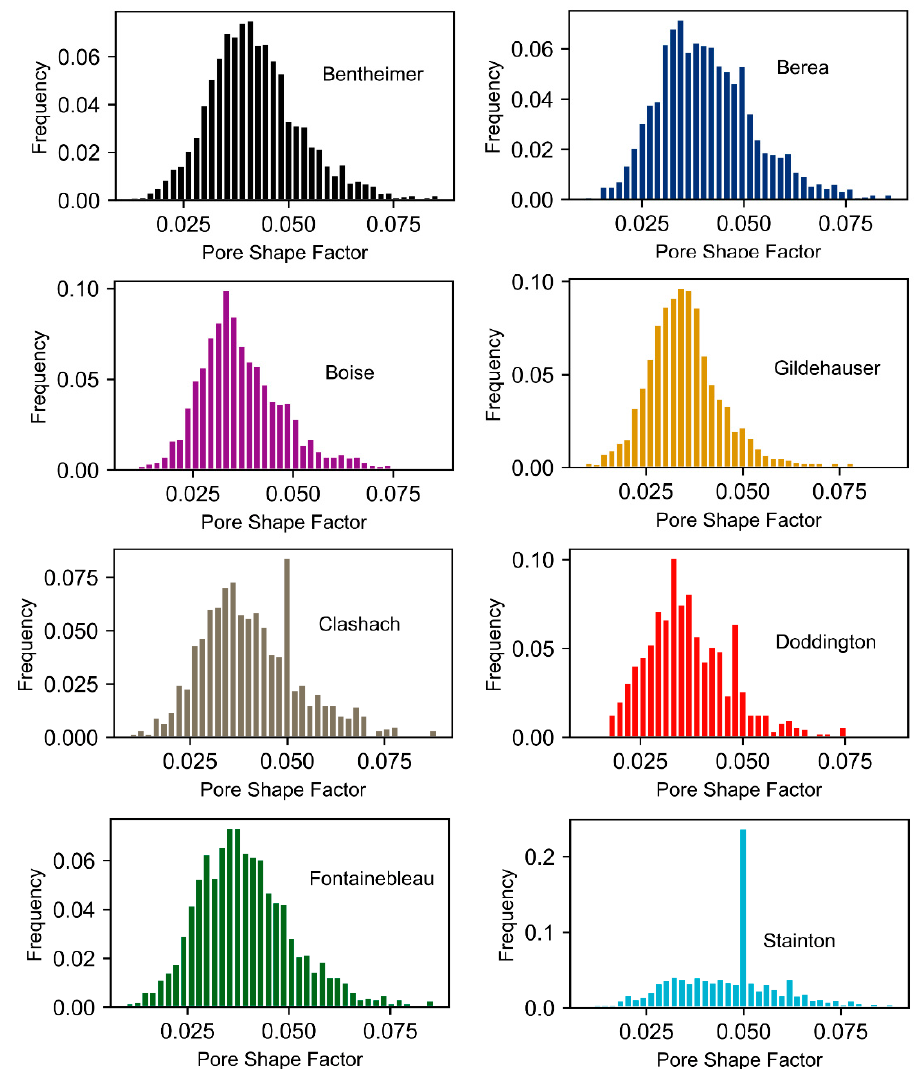
Figure 7. Pores shape factor distribution of eight sandstone samples.